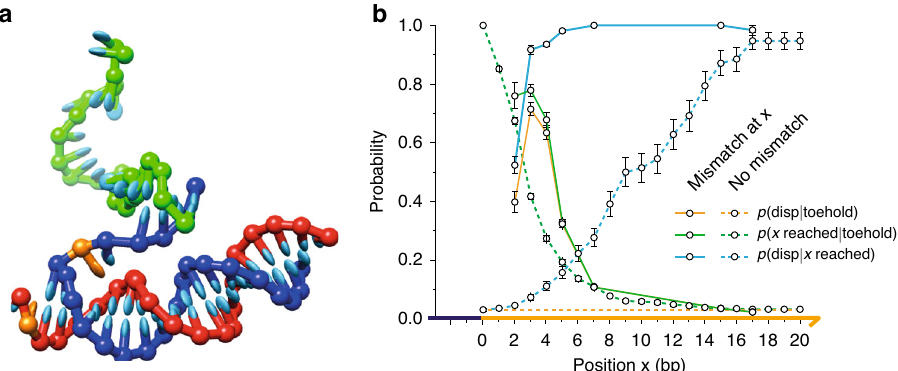
Fig. 3 oxDNA simulation of mismatch-elimination TMSD. a Snapshot from an oxDNA simulation showing the invader (green) binding to the toehold of the target (blue); the output (red) is bound to the displacement domain. The mismatched base pair, highlighted in orange, is at position 2; fraying of the OT duplex is visible. b Analysis of strand-displacement probabilities using oxDNA. The probability that the branch point reaches position x ( p ( x reached ∣ toehold)) and the probability of successful displacement given that x is reached ( p (disp ∣ x reached)) are plotted for a perfectly matched duplex (dashed green and blue lines, respectively) and a duplex with a mismatch at x (solid green and blue lines, respectively). Also shown is the overall displacement probability p (disp ∣ toehold) for the perfectly matched case and p (disp ∣ toehold) as a function of mismatch location (dashed and solid orange lines, respectively). Error bars show standard error on the mean for n = 6. The presence of a mismatch at position x enhances both the probability of reaching x and of successful displacement given that x is reached.